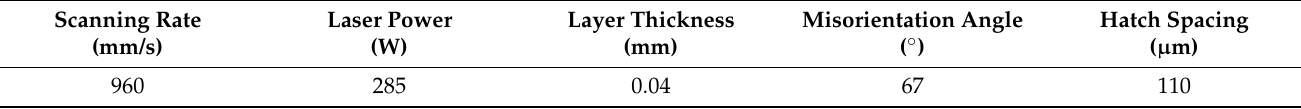
Table 2. Additive manufacturing parameters recommended by EOS GmbH.